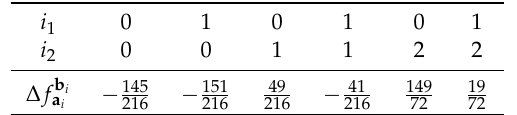
in Example 1. x , y p q